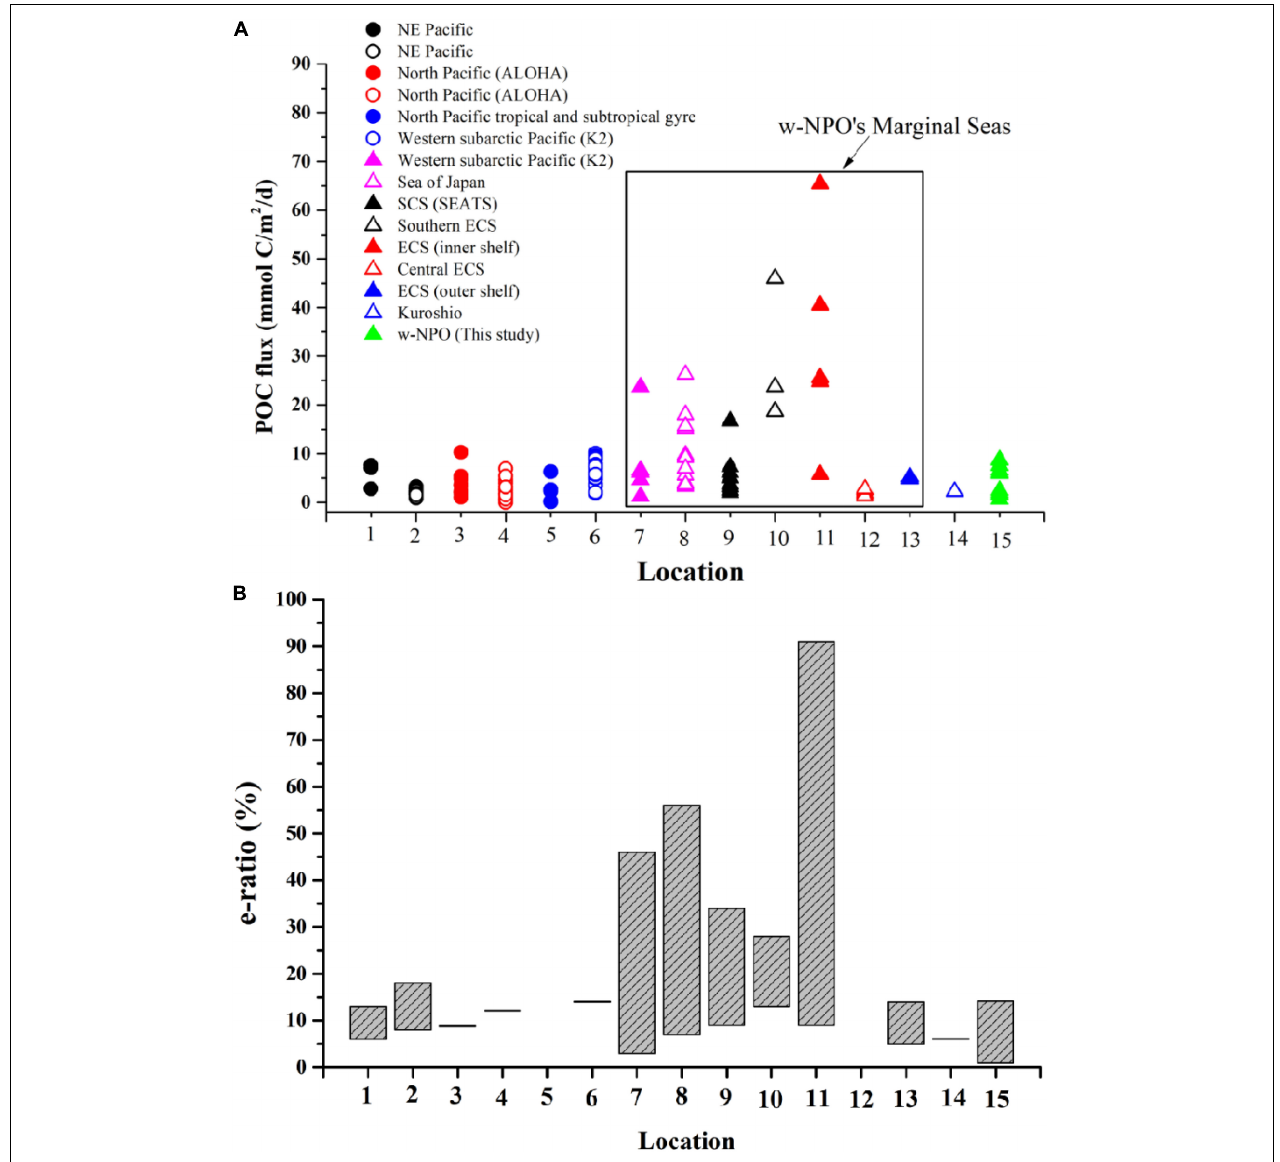
FIGURE 10 | Comparison of the POC export fluxes (A) and export efficiency (B) in different sea areas of the Pacific Ocean and its marginal seas. Data are derived from the references in Table 4 and this